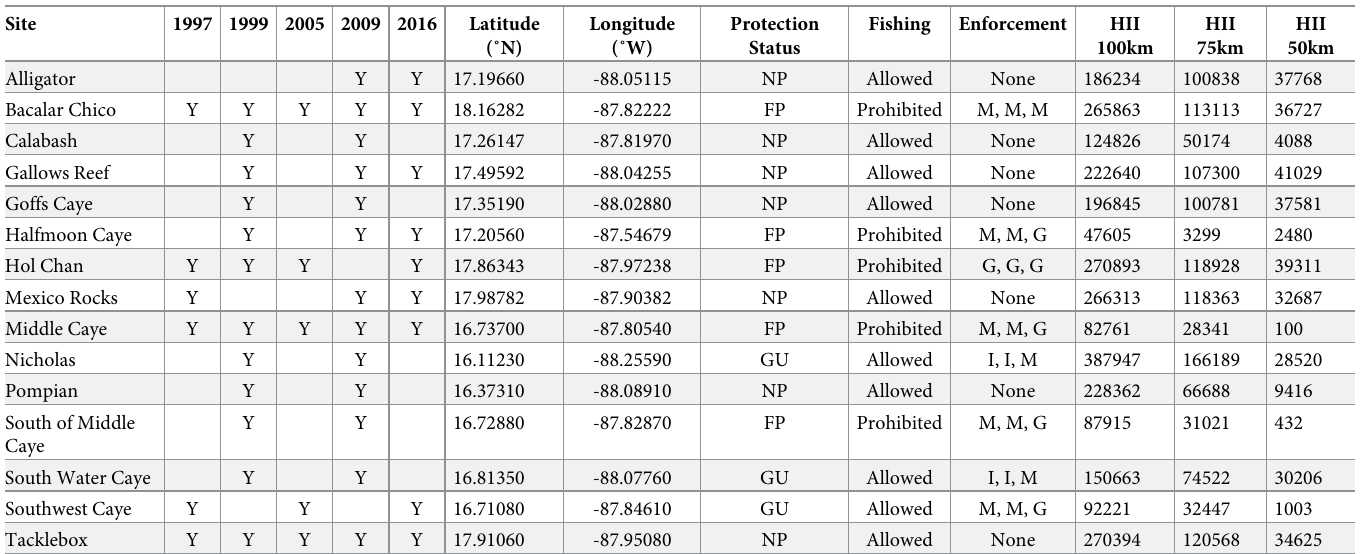
Table 2. Site-related